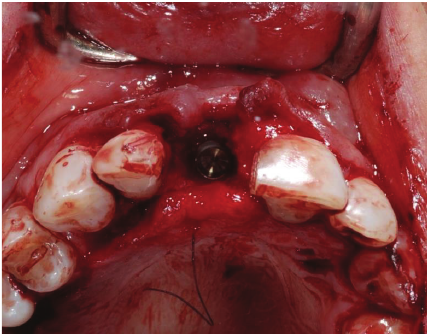
Figure 9: Occlusal view of the surgical incision at implant insertion time. A full thickness flap at the single gap continued with a partial thickness flap to harvest a connective tissue graft.